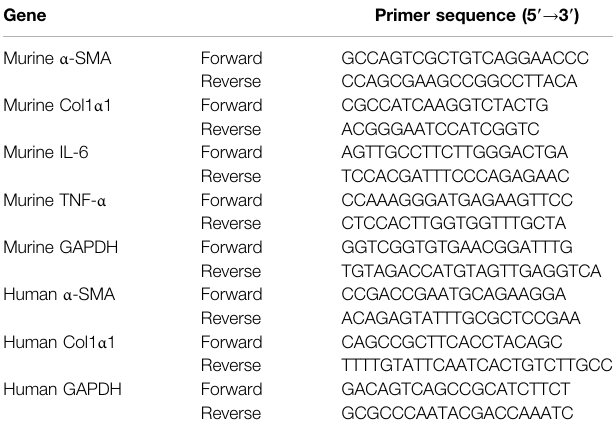
TABLE 1 | Primer Sequences Used for qRT-PCR Analysis. Gene